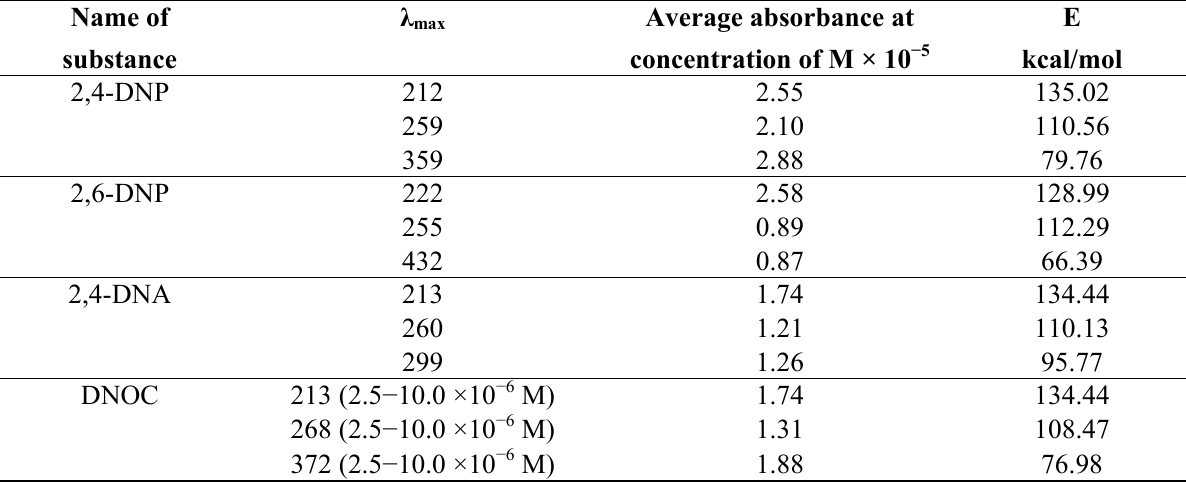
Table 3. Average absorbance and radiant energy absorbed by one mole of substance calculated for 1 M solutions of nitro compound.